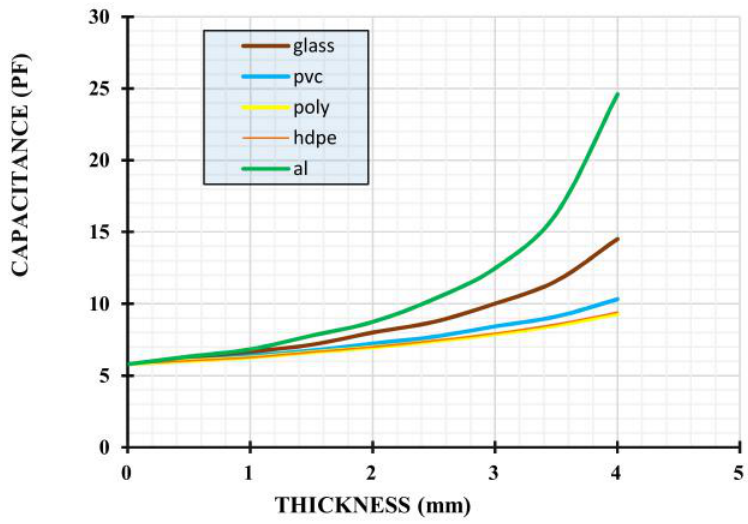
Figure 12. Variation of capacitance with dielectric thickness